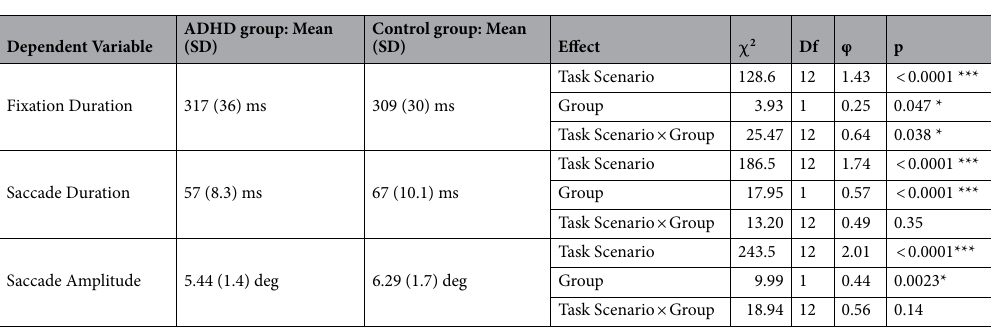
Table 2. Test statistics and Mixed Effect Models for the main eye movement